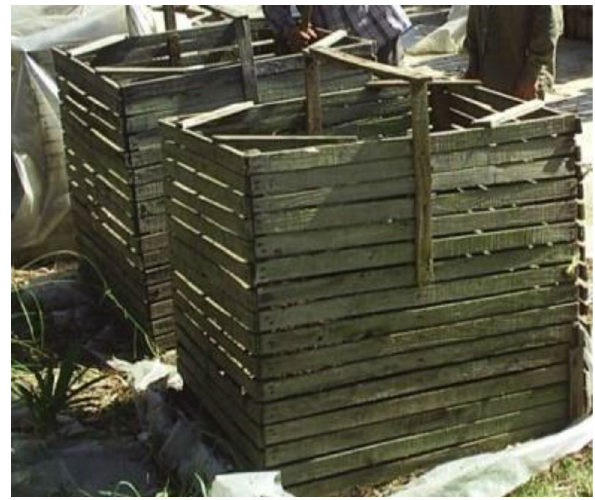
Fig. 1 Used wooden box to produce peanut shell + Azolla compost